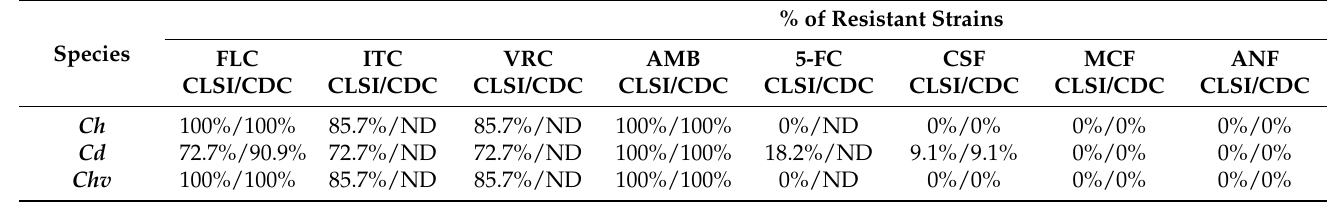
Table 4. Percentage of resistant strains of C. haemulonii species complex studied herein based on both CLSI and CDC